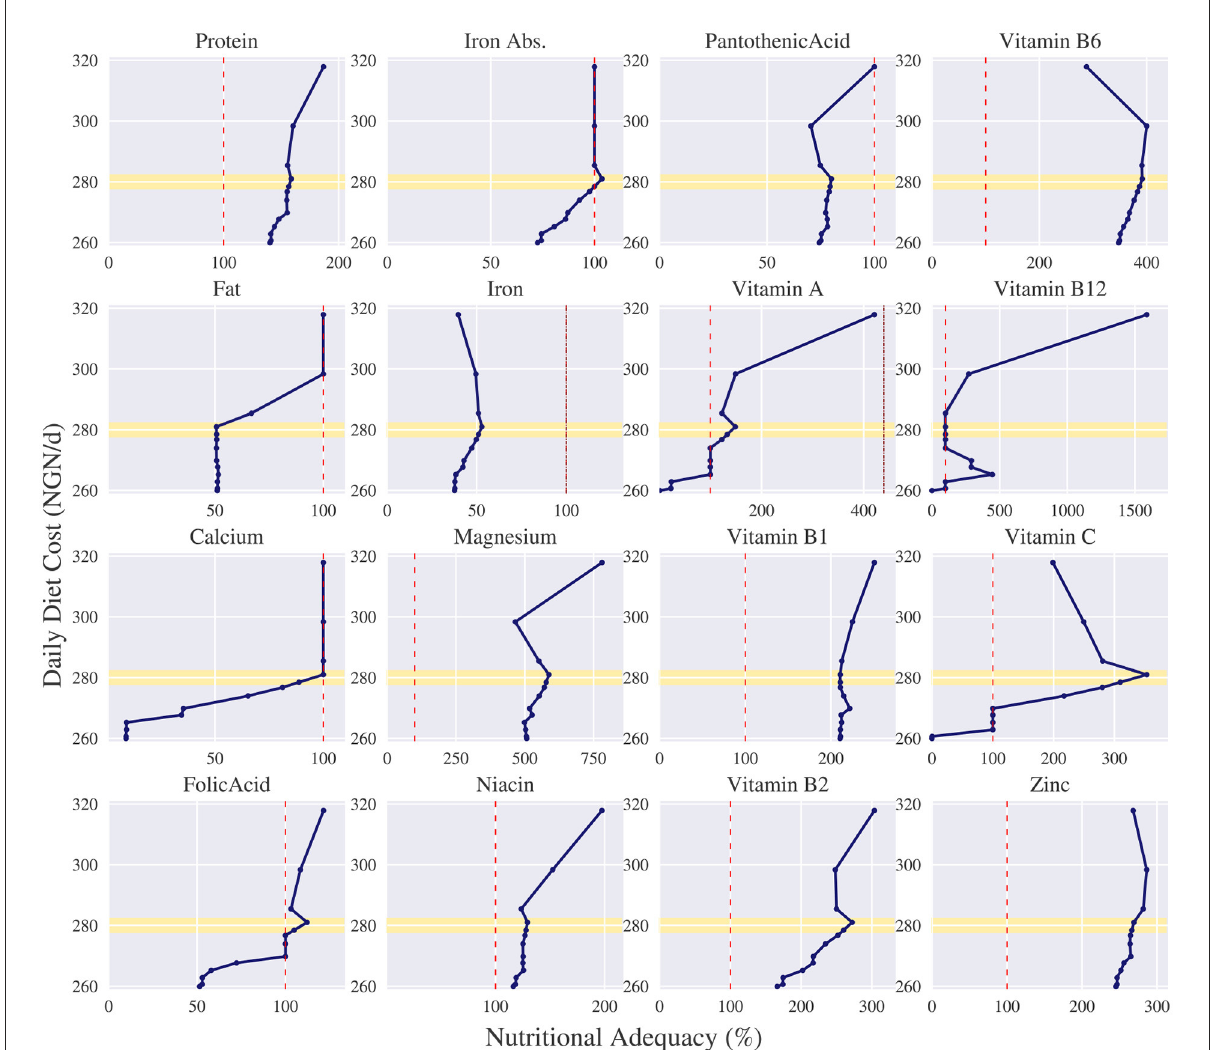
FIGURE5 Nutritional adequacy per nutrient corresponding to the trade-offs of the daily diet cost in Nigerian naira (NGN/d) vs. nutritional deviation measured as summed deviation for the omnivore diet for an adolescent female of 16–17 years. in Ebonyi. For all nutrients, except iron, the adequacy is measured relative to their lower limit (100%). As iron only has an explicit upper limit, we measure its adequacy relative to its upper limit (100%). The daily cost of each dot corresponds to the daily cost on the Pareto curve. The lower limit of each nutrient is indicated with a red dotted line. If applicable, the upper limit is indicated with a dark red dotted line. The yellow highlighted area indicates a price level around 280 NGN.